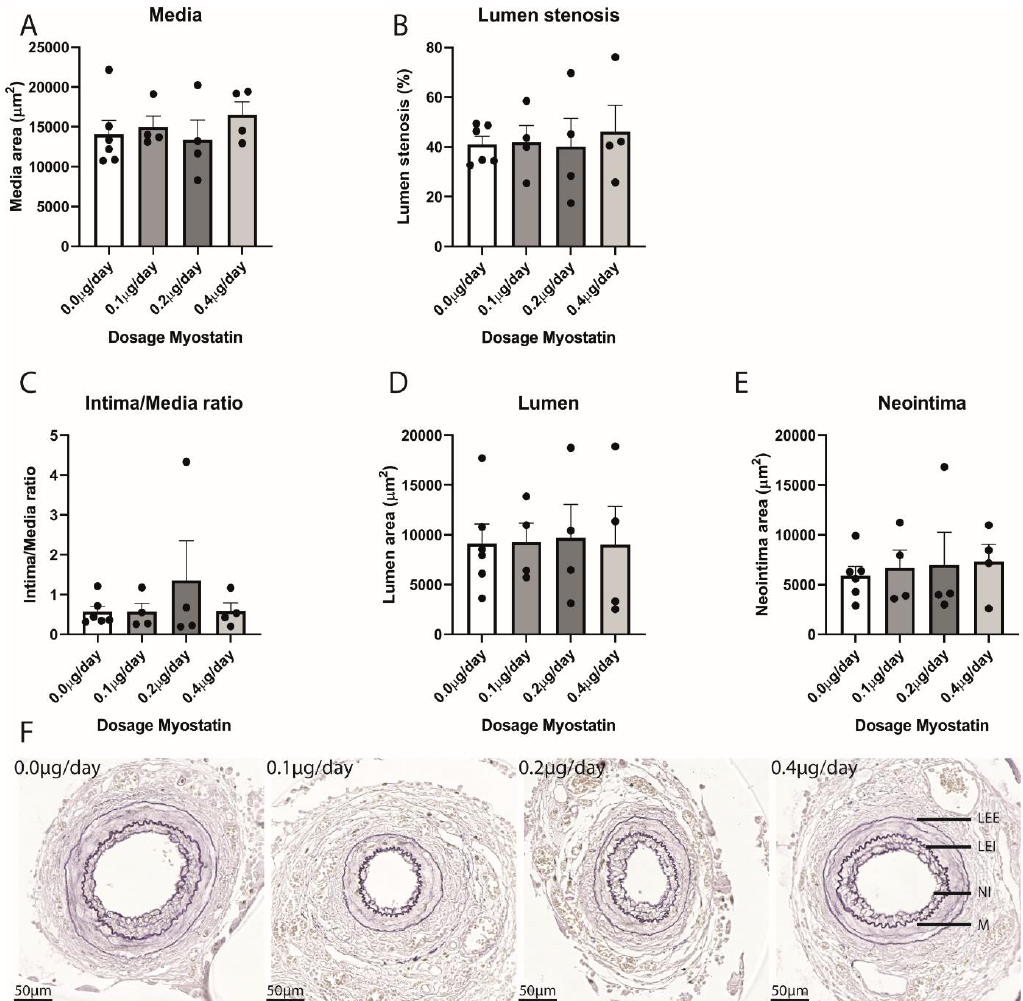
Figure 4. ( A – F ): Quantification of restenosis in cuffed femoral arteries in different treatment groups. ( A )—Media area was similar in different treatment groups. ( B )—Lumen stenosis did not differ between treatment groups. ( C )—Intima / Media ratio was similar in different treatment groups. ( D )—Lumen area in different treatment groups was equal. ( E )—Neointima area in different treatment groups did not differ. ( B – E ): Quantification of not occluded arteries. Mean expression is shown and error bar represents SEM. n = 7 in control group, n = 4 in 0.1 µ g / day, n = 4 in 0.2 µ g / day, n = 4 in 0.4 µ g / day.